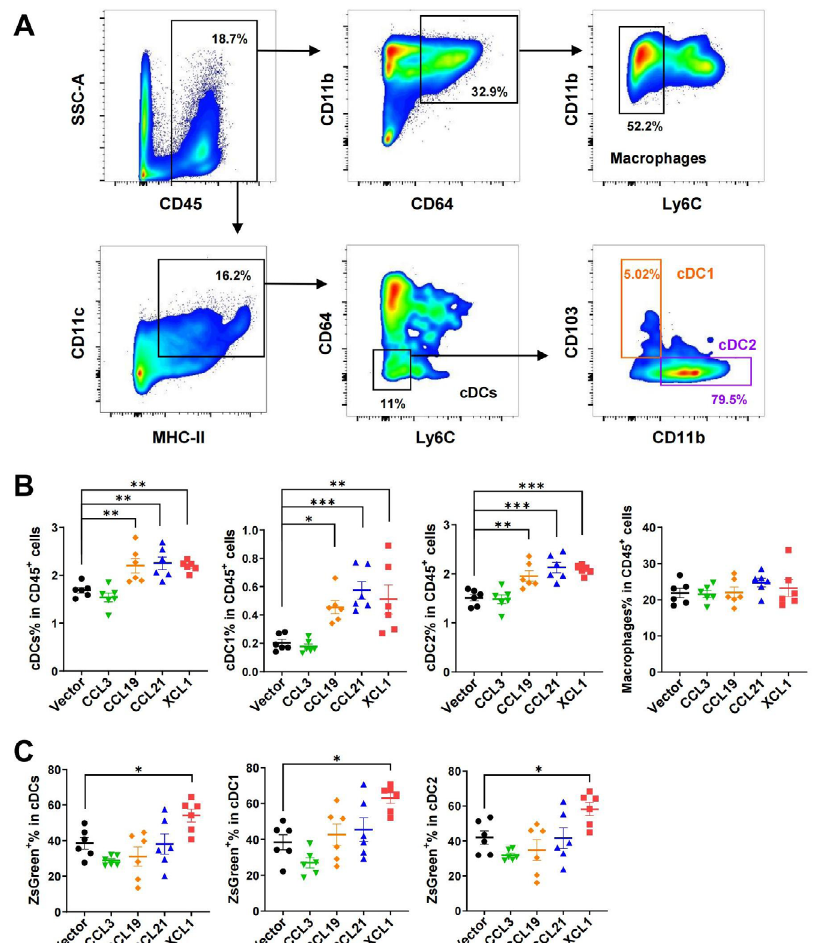
Figure 5. FACS analysis of tumor-infiltrating cDCs and macrophages in MC38 tumor model. A. Gating strategies for cDCs, cDC1, cDC2, and macrophages; B. ratios of cDCs, cDC1, cDC2, and macrophages in CD45 + cells; C. ratios of ZsGreen + cells in